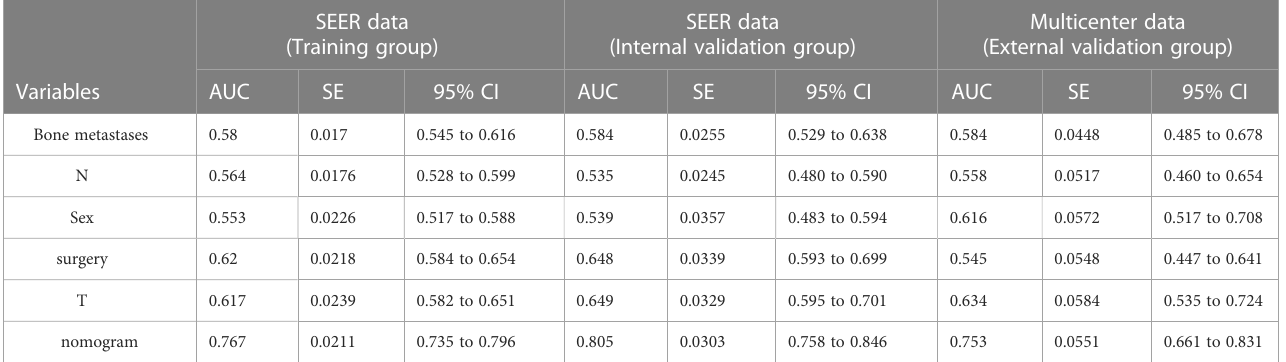
TABLE 4 AUC of training group and validation group.